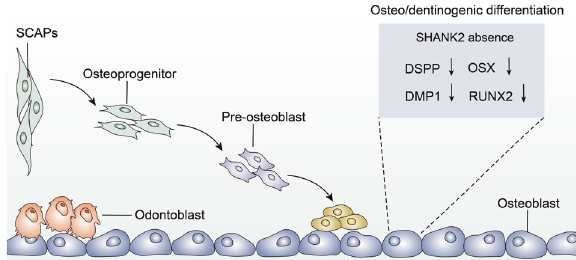
Fig. 5 Schematic diagram representing the effects of SHANK2 on the differentiation of SCAPs. SHANK2 regulates osteo/dentinogenic differentiation in SCAPs via DSPP, DMP1, OSX and RUNX2.